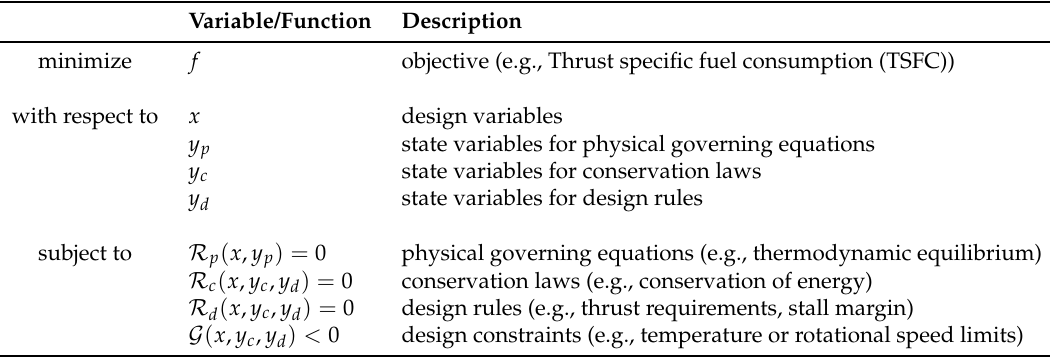
Table 1. General mathematical problem formulation for the optimization of a turbine engine cycle.